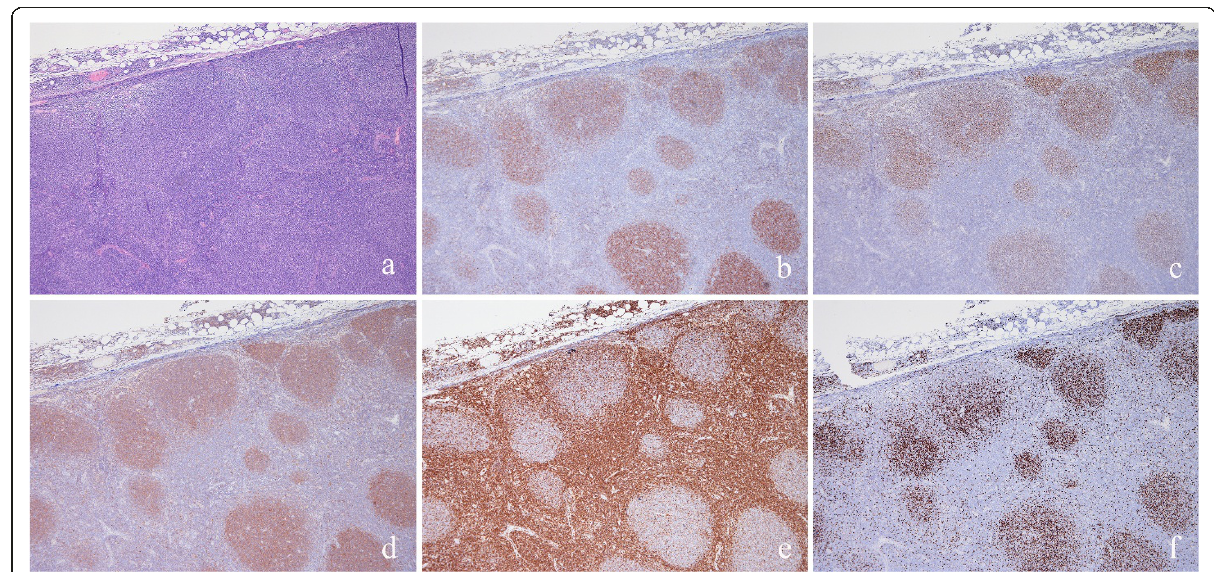
Figure 2 Invasive follicular lymphoma . FL is formed by large nodules with interfollicular invasion (a) showing positive staining for CD10 (b), BCL6 (c), HGAL (d); the positivity for GC markers are more evident in the nodular component than in the interfollicular areas in this case. BCL2 was moderately and partially expressed (e). Ki67 proliferative index was high